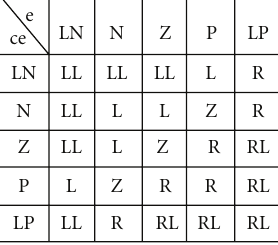
Figure 15: Rule matrix for the inverted pendulum on a cart system.